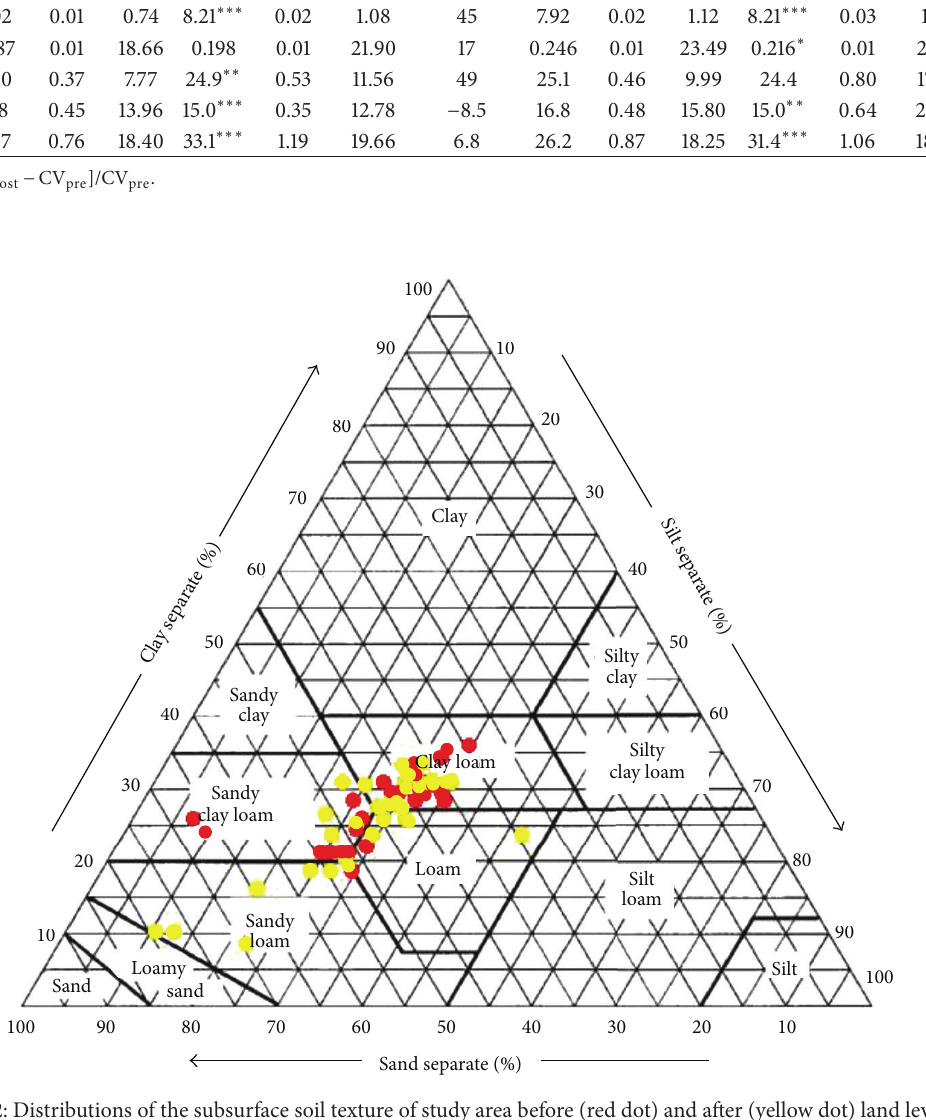
soil, preleveling PWP values ranged from 10.7 to 22.7% and averaged 16.8% (SE = 0.48 and CV = 15.80). After the land leveling, the PWP values of subsurface soil ranged from